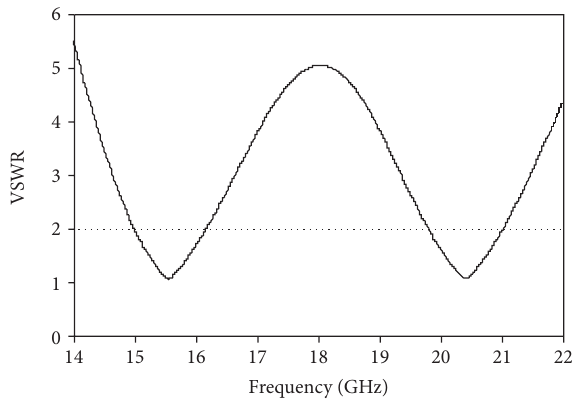
Figure 9: VSWR of the proposed antenna.